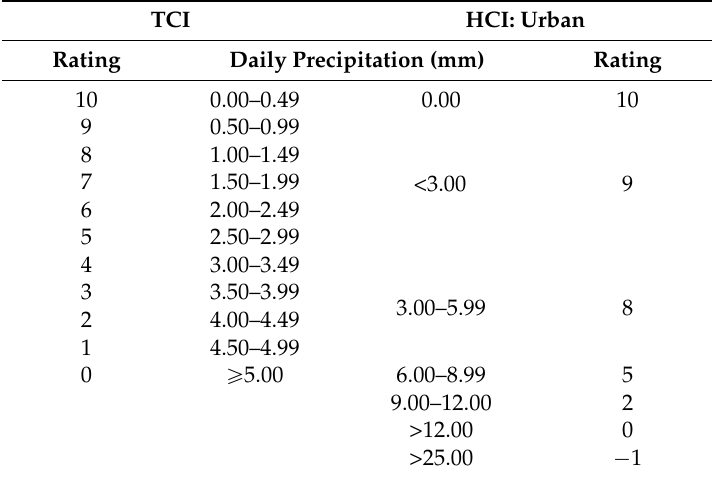
Table 5. Comparison of the precipitation rating